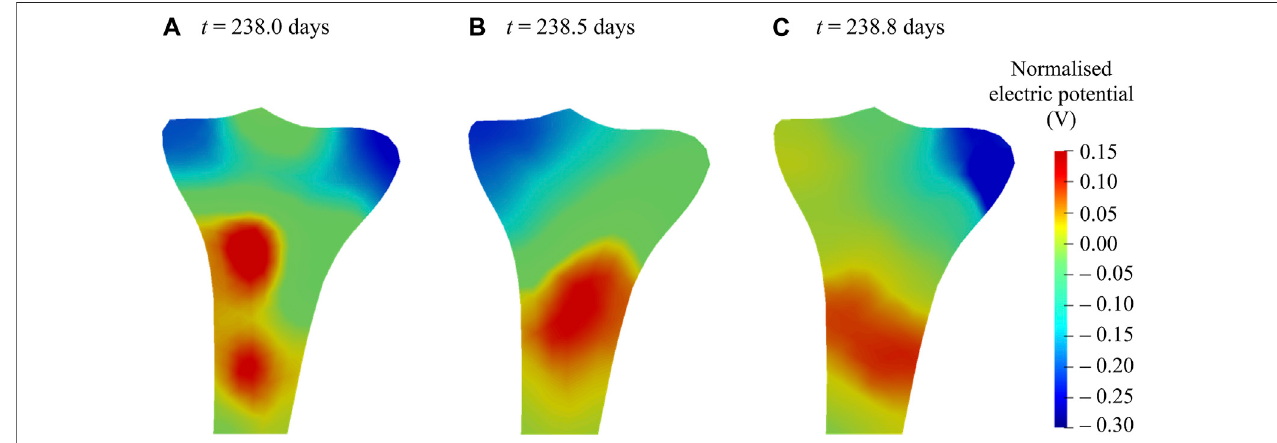
FIGURE 10 | Normalized electric potentials generated at various time instants of the 238th day due to the application of varying mechanical loads during walking.